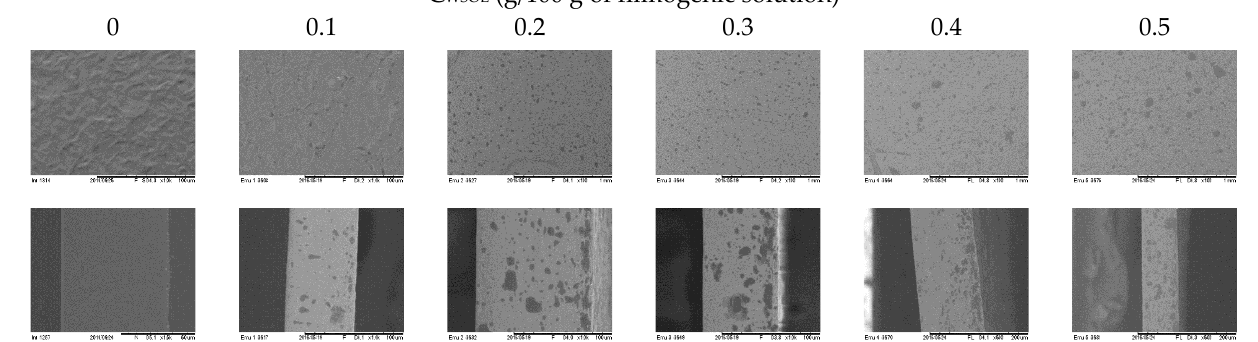
Figure 1. Effect on the surface and internal structure of cross-linked cassava starch-based films with different concentrations of watermelon seed oil emulsions (C WSOE , g/100 g of filmogenic solution).